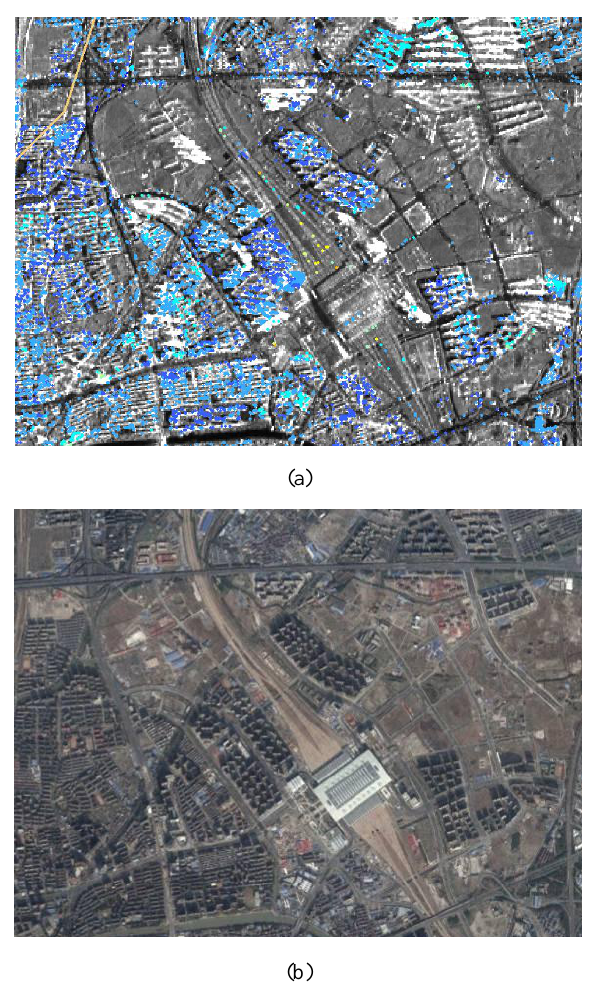
Figure 4. Average subsidence velocity around the Hangzhou East Railway Station (a) and corresponding optical image (b) provided by Google Earth.